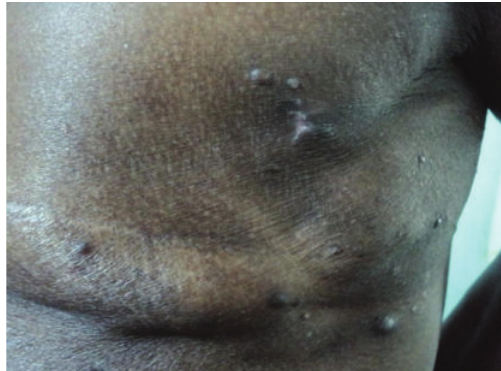
Figure 1: Multiple skin papules and nodules around the mastec- tomy scar—Case 1.